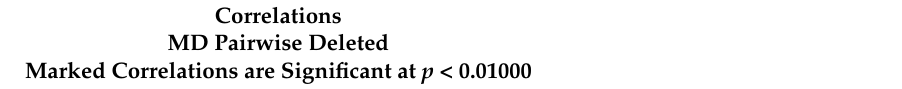
Table 3. Correlation of the quality of restoration according to USPHS (Success restoration) and the success of clinical parameters (Success).